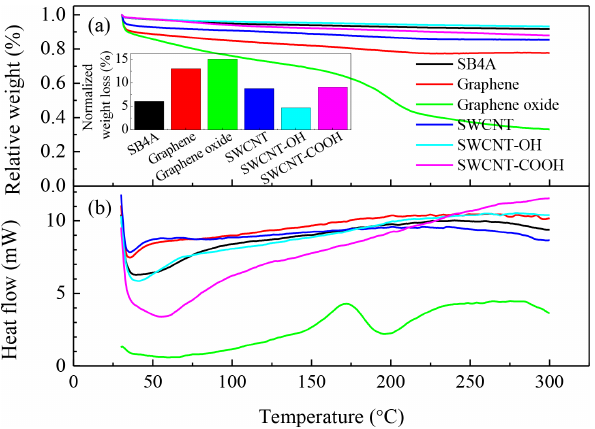
Figure 3. (a) Thermogravimetric curves of carbon nanomaterials in nitrogen gas flow; (b) the corresponding differential thermal analy- sis curves. The inset graph shows the weight loss due to desorption of organics.